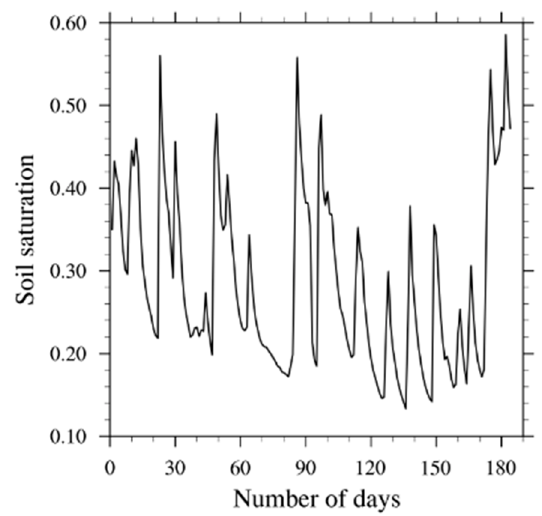
Figure 1. Value distribution of daily soil saturation in two summers (i.e., 184 days) of 2016–2017 at Pingliang station.